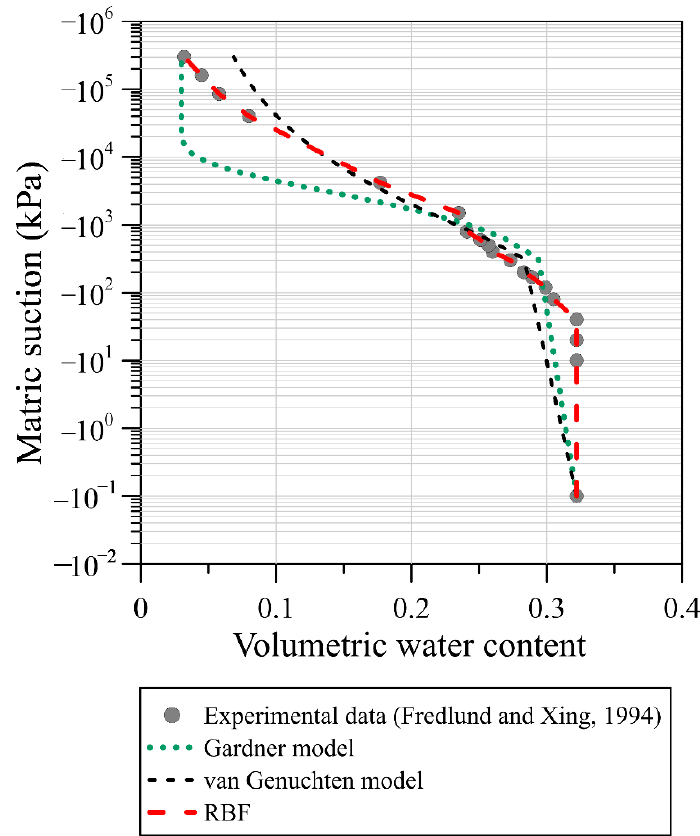
Figure 1. The fitted results of the SWCC.